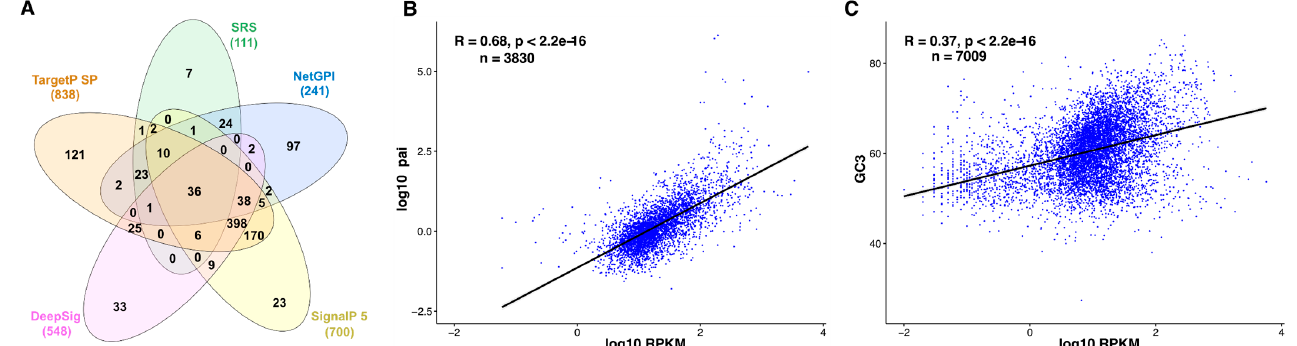
Figure 1. In silico analyses of Toxoplasma gondii proteins. A. Venn diagram [127] illustrating the number of SRS proteins with respect to having either a signal peptide and/or a GPI anchor, as predicted by different algorithms. For details see text. B. Genome-wide correlations between protein and RNA abundance in T. gondii. Correlation in tachyzoites between mean of transcript levels (expressed as log10 of reads per kilobase of transcript per million mapped reads, RPKM) and protein abundance (expressed as log10 of protein abundance index, PAI) reported by [105] and [128] . Analysis is based on 3830 genes/proteins shared by both data sets. C. Similar correlation analysis with GC3 calculated from 7009 gene data shared by both data sets, using CodonW 1.4. Statistical analysis was performed with the R package ggpubr 0.4.0., reporting the Pearson correlation coefficient.